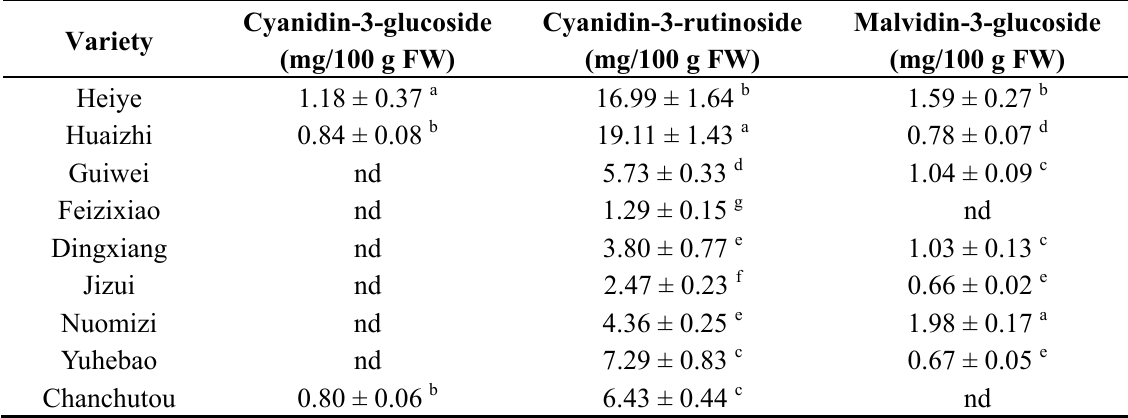
Table 2. Profiles of anthocyanins in litchi pericarp of nine